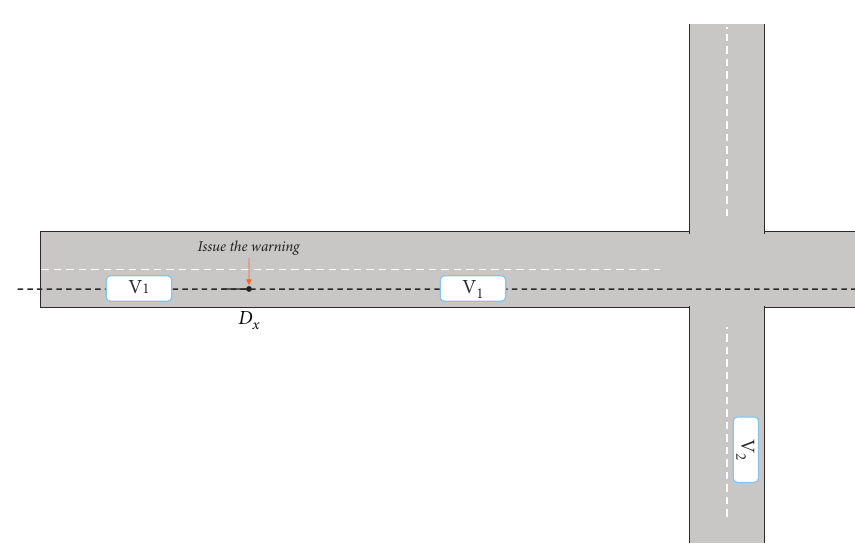
Figure 4: The process of the driver approaching intersection.